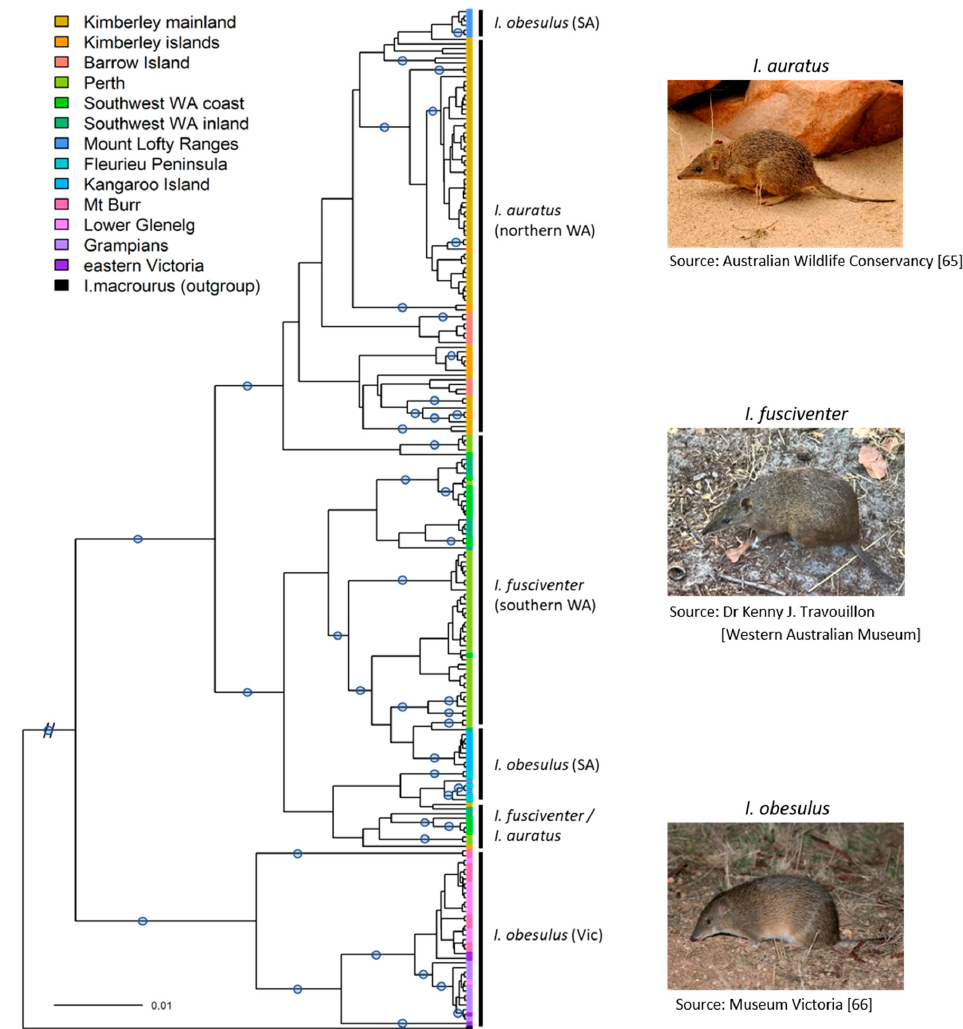
Figure 2. Results of Bayesian phylogenetic analysis in BEAST of D-loop mitochondrial sequences from Isoodon obesulus (Vic, SA), I. fusciventer , and I. auratus . Posterior probability values above 0.9 are indicated by grey circles overlaid on branches. Isoodon macrourus was used as an outgroup. Photo credits: I. auratus Australian Wildlife Conservancy [65], I. fusciventer Dr Kenny Travouillon, Western Australian Museum, I. obesulus Museums Victoria